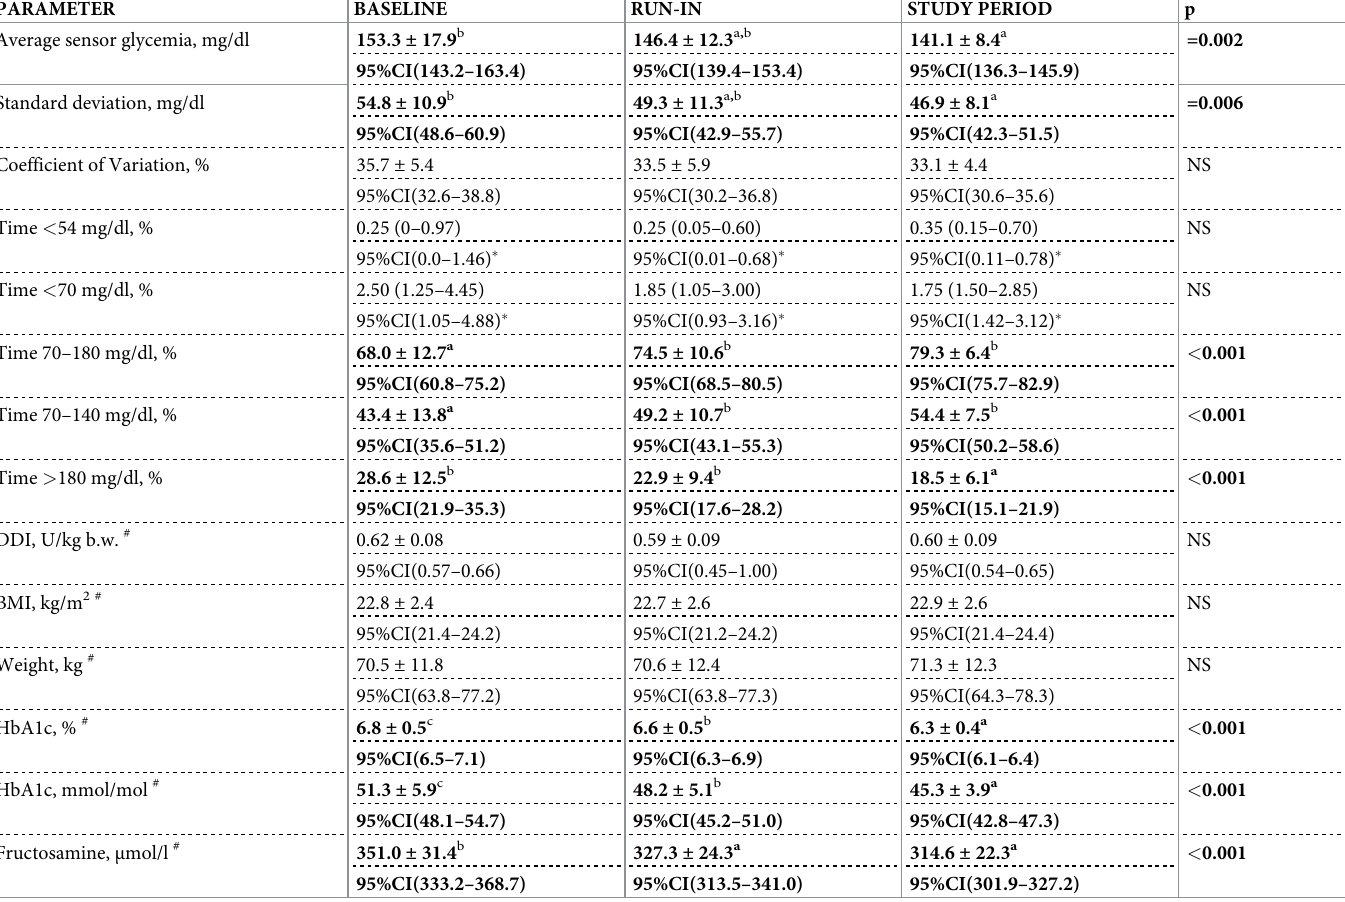
Table 2. Comparison of glycemic outcomes and insulin requirement in the study, run-in and baseline periods.